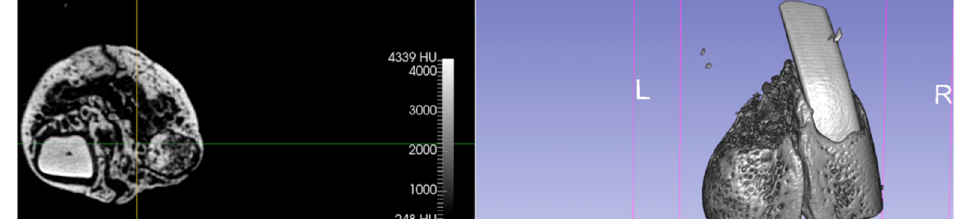
Figure 2. Coronal section and tridimensional reconstruction of the test group extractive socket at a 90-day evaluation.